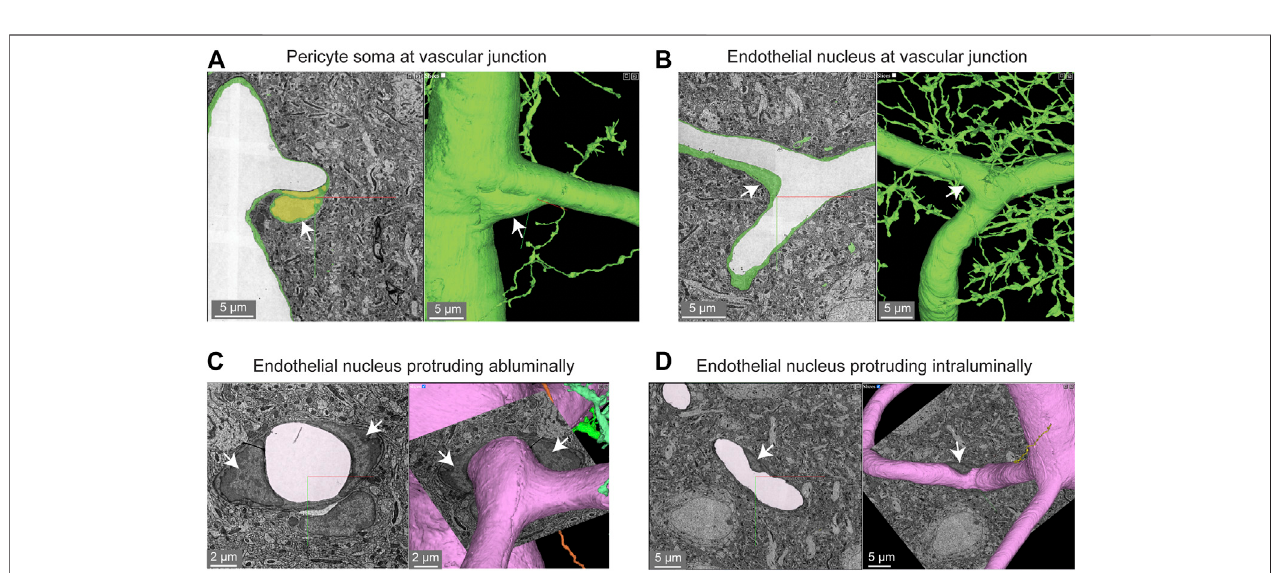
FIGURE 2 | Pericyte and endothelial cell somata can be positioned at vascular junctions. (A) Pericyte soma (white arrow) positioned at the junction between the capillaryandascendingvenuleintheMICrONSLayer2/3dataset.Leftpanelshowsselectedvascularwallsegmentationin2D,andtherightpanelshows3Drenderingof the vascular wall. MICrONS Layer 2/3 x, y, z coordinates at: 82286, 68574, 1719. (B) Endothelial nucleus (white arrow) at a capillary junction. Coordinates at: 68291, 61335, 1788. (C) Example of two endothelial nuclei that protrude abluminally without affecting the shape of the lumen. Coordinates at: 76691, 59357, 1,594. (D) Example of an endothelial nucleus that protrudes intraluminally and causes local reduction in capillary diameter. Coordinates at: 71372, 45504, 1,467.